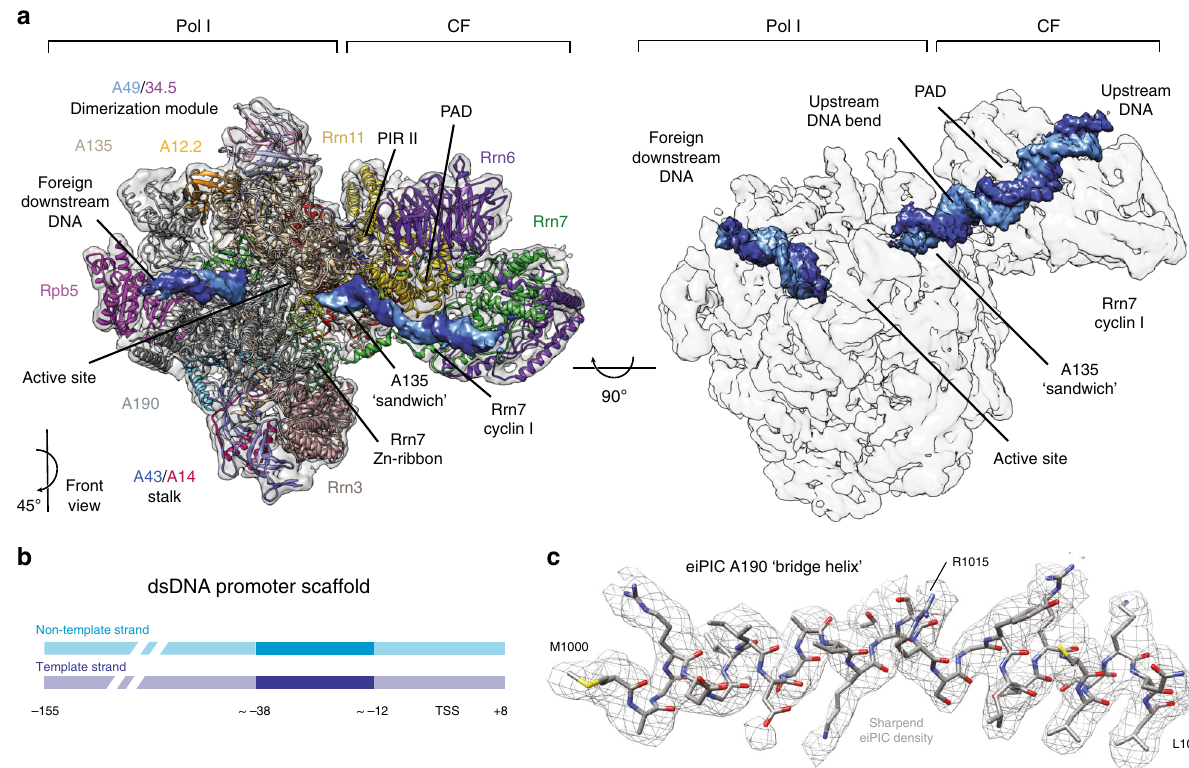
Fig. 1 Cryo-EM reconstruction of a Pol I early intermediate PIC. a Overview of the Pol I eiPIC cryo-EM reconstruction at 3.5 Å resolution (unsharpened; transparent gray envelope) overlaid with the PDB model (colored ribbon) and DNA (space fi ling). The right panel shows transparent density (gray) for protein components and solid density for the DNA path (template strand in blue and non-template in light blue). PAD promoter-associated domain (of Rrn11); PIR polymerase interacting region (of CF). b Schematic representation of promoter dsDNA used for PIC assembly, densities observed in the eiPIC reconstruction are highlighted in blue and light blue for template strand and non-template strand, respectively. c Atomic model of the bridge helix in subunit A190 overlaid with sharpened eiPIC density (gray mesh) indicates residue